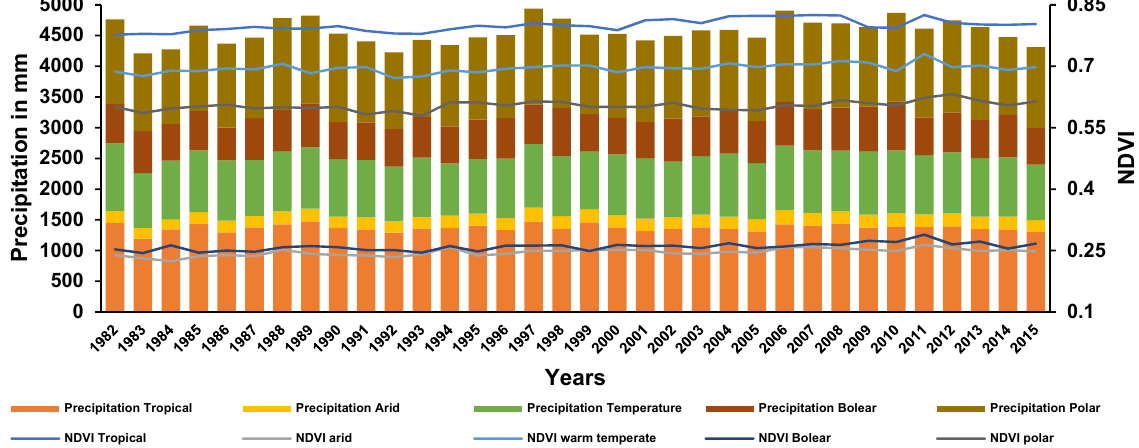
Figure 8. Consistency Between NDVI3g and Precipitation interannual variation in all African climate zones in 34 years of the study.